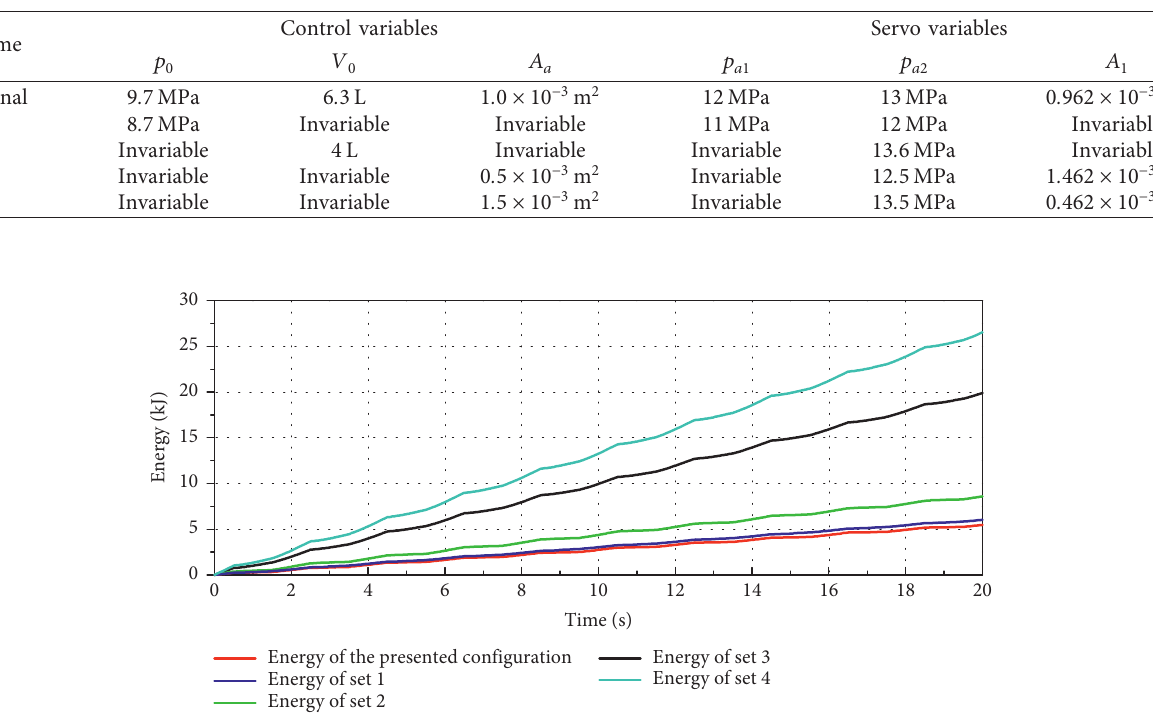
Figure 14: Comparison of the energy-saving effect of different parameter configurations of the hydraulic